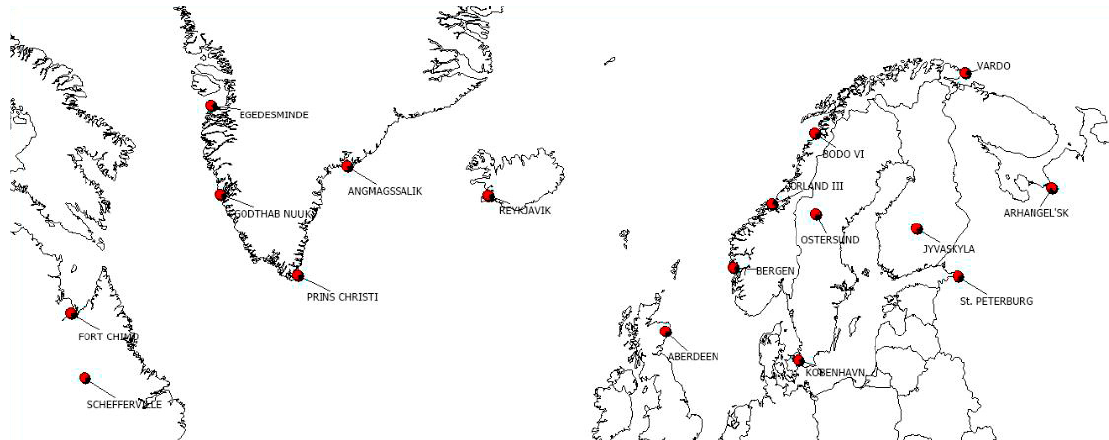
Figure 1. Location of weather stations.